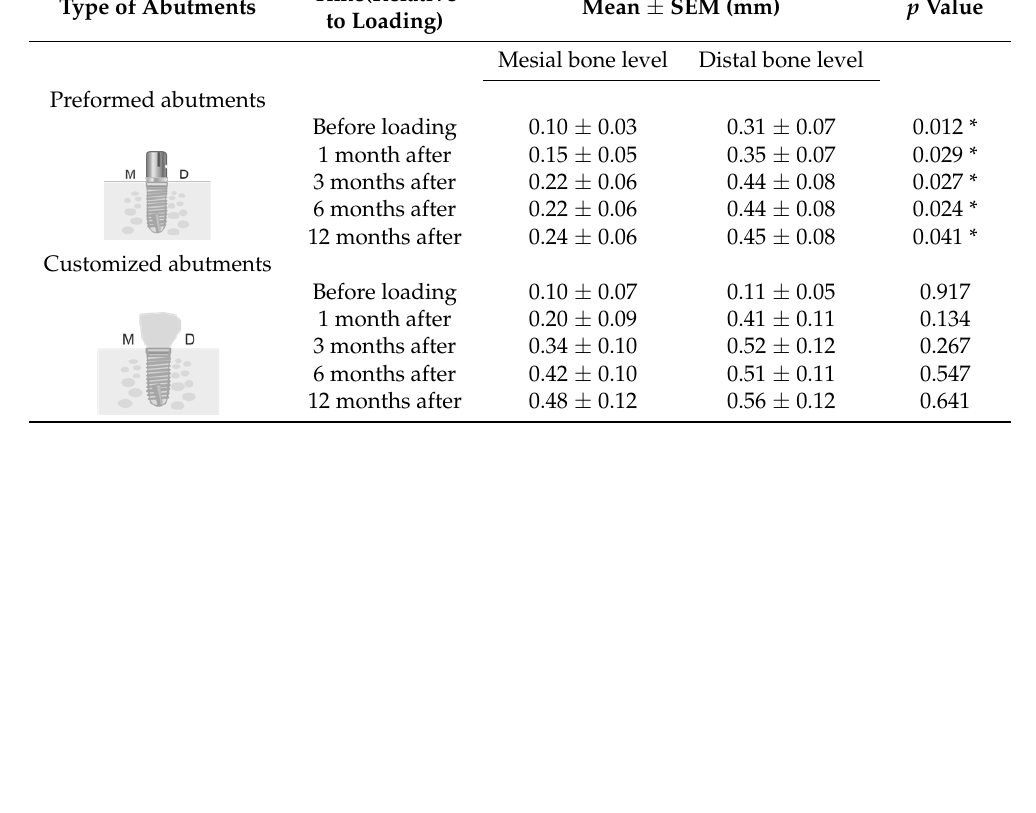
Table 3. Mesial and distal bone levels in each period. SEM, standard error of measurement. (* p < 0.05, by two-tailed t -test.).